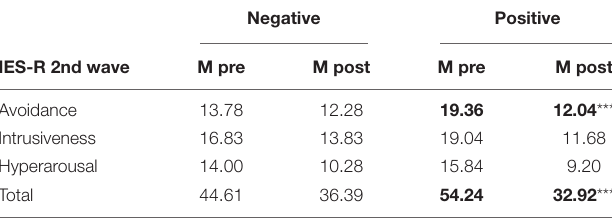
TABLE 5 | Second wave HCW positive and negative to